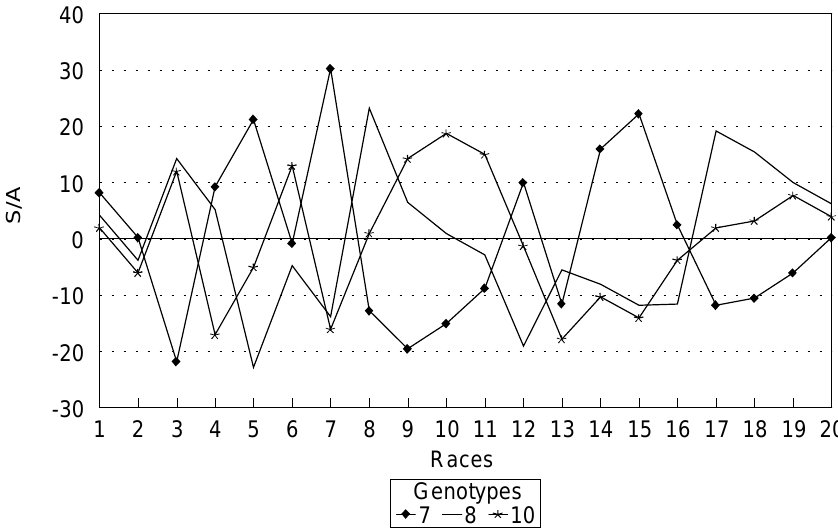
Figure 2 - Specific interaction ability (SIA) of some hosts inoculated with different pathogen races according to interactive